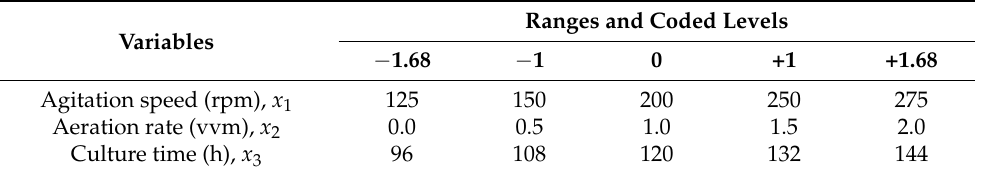
Table 1. Experimental ranges and coded levels of the independent variables used in the